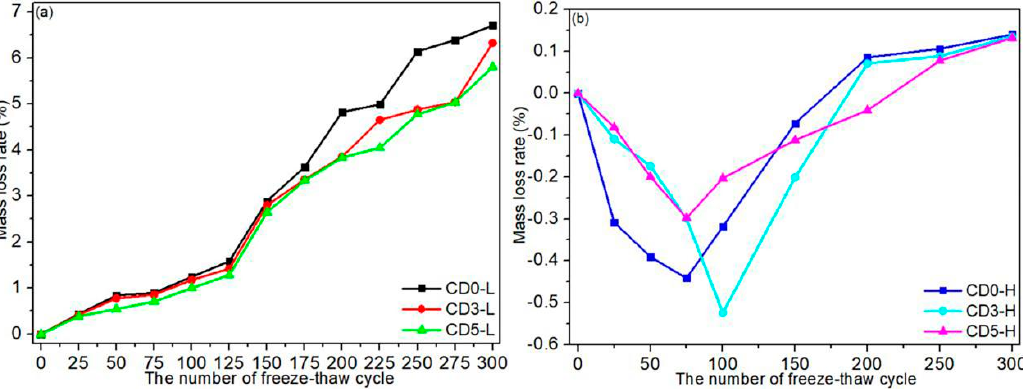
Figure 6. The relationship between the mass loss rate and the number of freeze–thaw cycles of concretes incorporating dolomite powder: ( a ) C30 concretes; ( b ) C45 concretes.